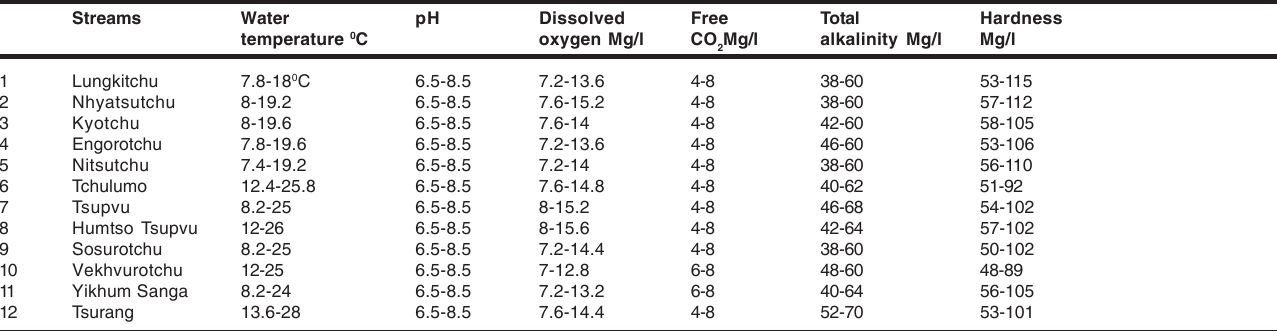
Table 1. Physico-chemical parameters of the 12 streams (after APHA